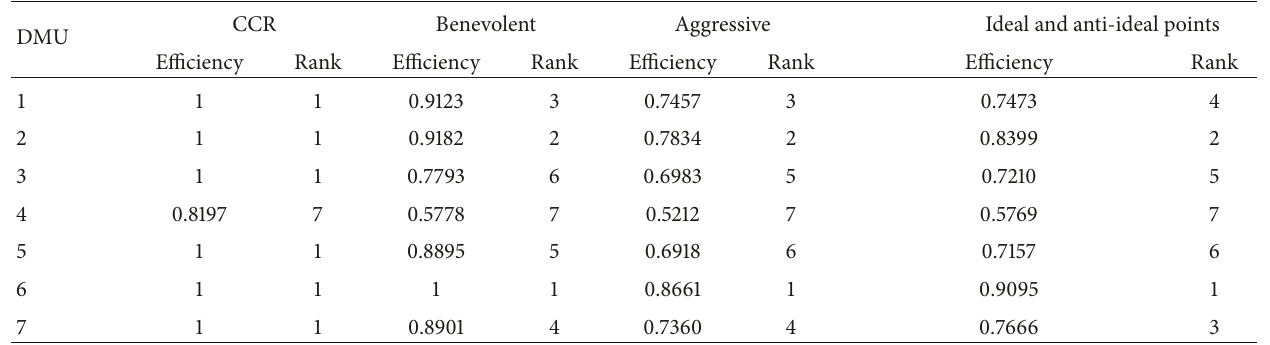
Table 2: Efficiency rating and the proposed model values for the seven DMUs.